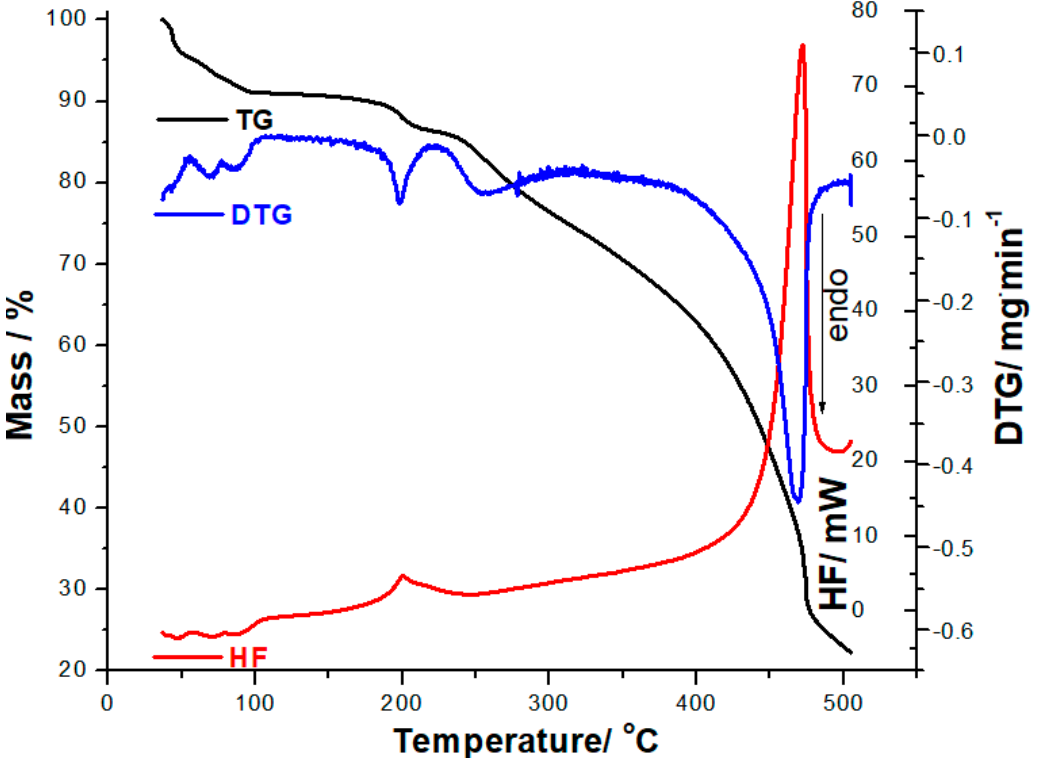
Figure 3. Thermoanalytical curves (thermogravimetric TG / derivative thermogravimetric DTG / heat flow HF) obtained at β = 10 °C·min − 1 in dynamic air atmosphere for LTSS.